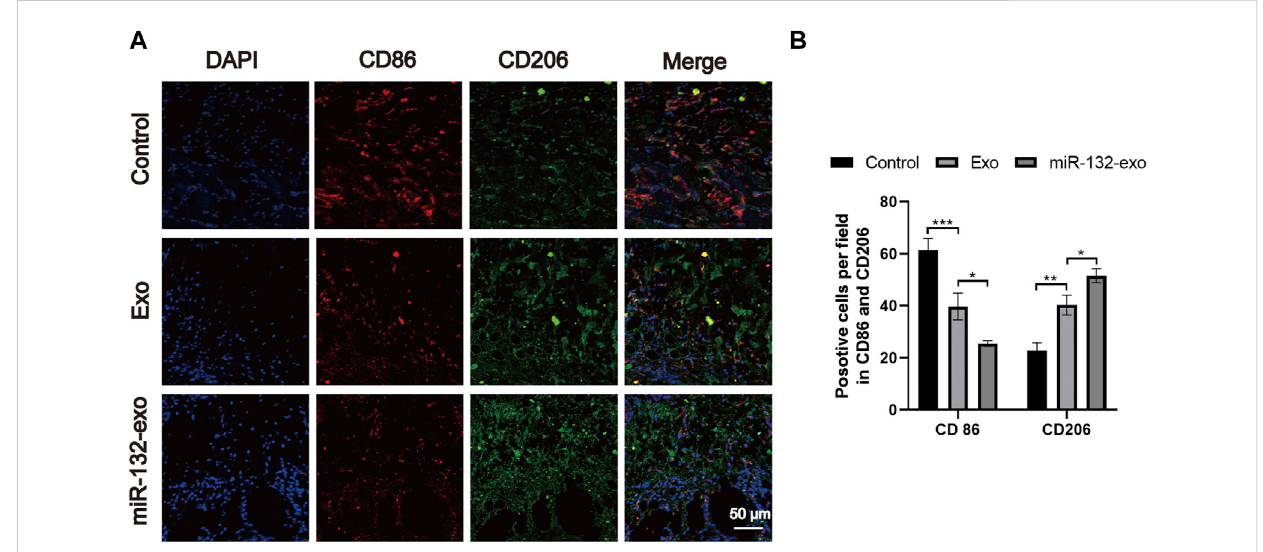
FIGURE 6 The miR-132-exo stimulated M2 polarization of macrophages in diabetic random skin fl aps. (A) Representative co-staining images of CD86 and CD206 in each group, scale bar = 50 μ m; (B) Quanti fi cation analysis of positive stained macrophages by CD86 and CD206. * p < 0.05, ** p < 0.01, *** p < 0.001, data are presented as the mean ± SD, n =